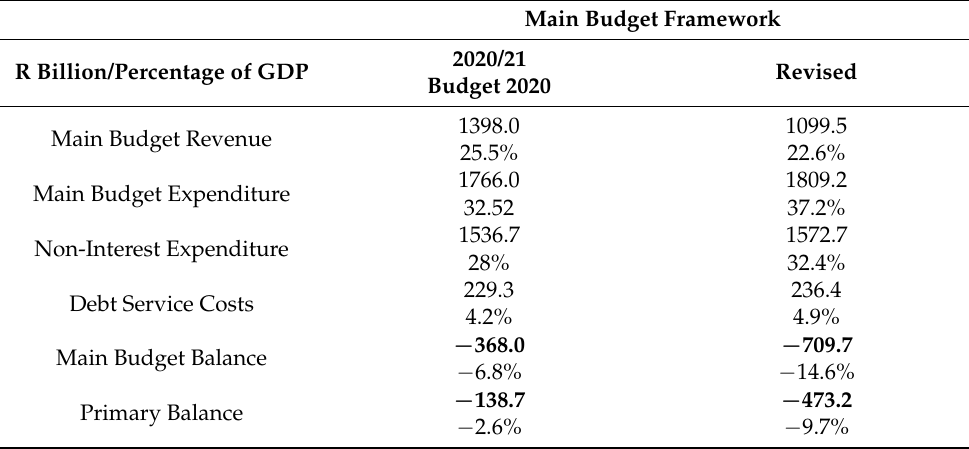
Table 2. South Africa’s fiscal response to the COVID-19 pandemic.